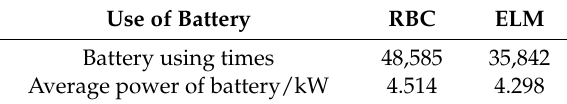
Figure 15. Output power of the battery. Table 7. Results of the battery in the rule-based controller (RBC) and extreme learning machine